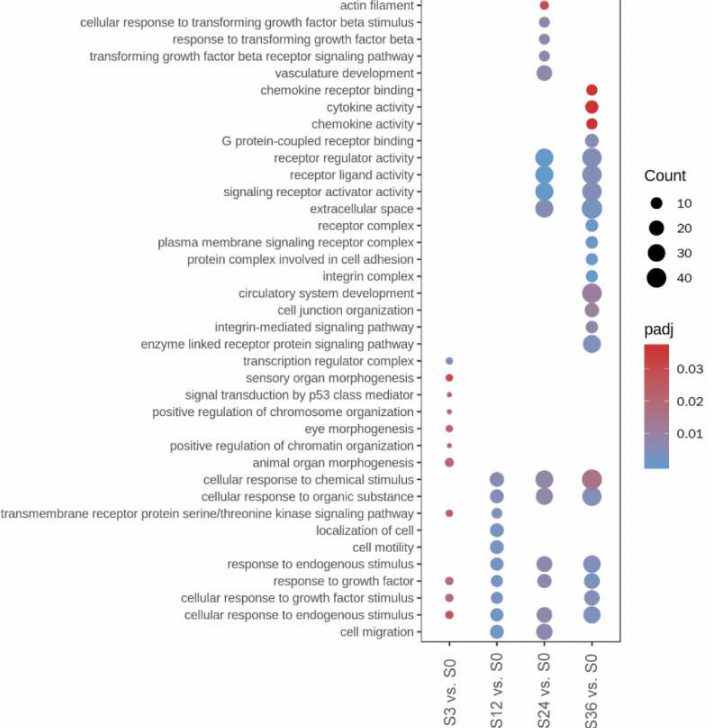
Figure 3. Go function enrichment analysis of DEGs. The top 10 significantly enriched Go terms from each category (BP, CC, and MF) are shown. The size of the dots indicates the number of DEGs enriched in the term (Count). The color of the dots indicates the adjusted p -value (padj), with a bluer color indicating smaller padj value. The terms related to “response to stimulus or growth factor” are enriched from 12 to 36 hpi. Detailed information on the enriched Go terms is collected in Tables